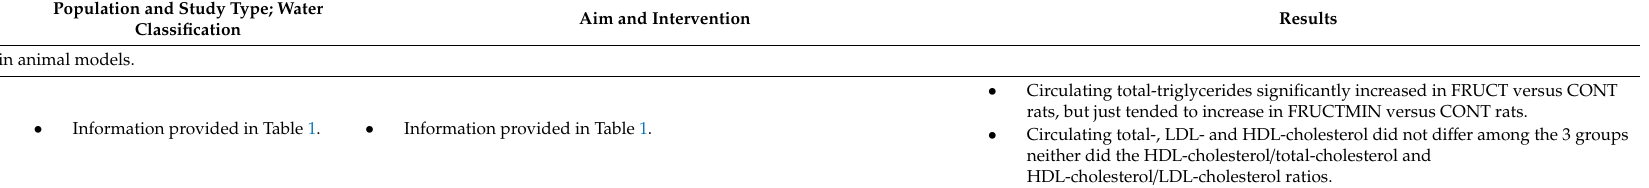
Table 2. The influence of mineral water consumption upon lipid